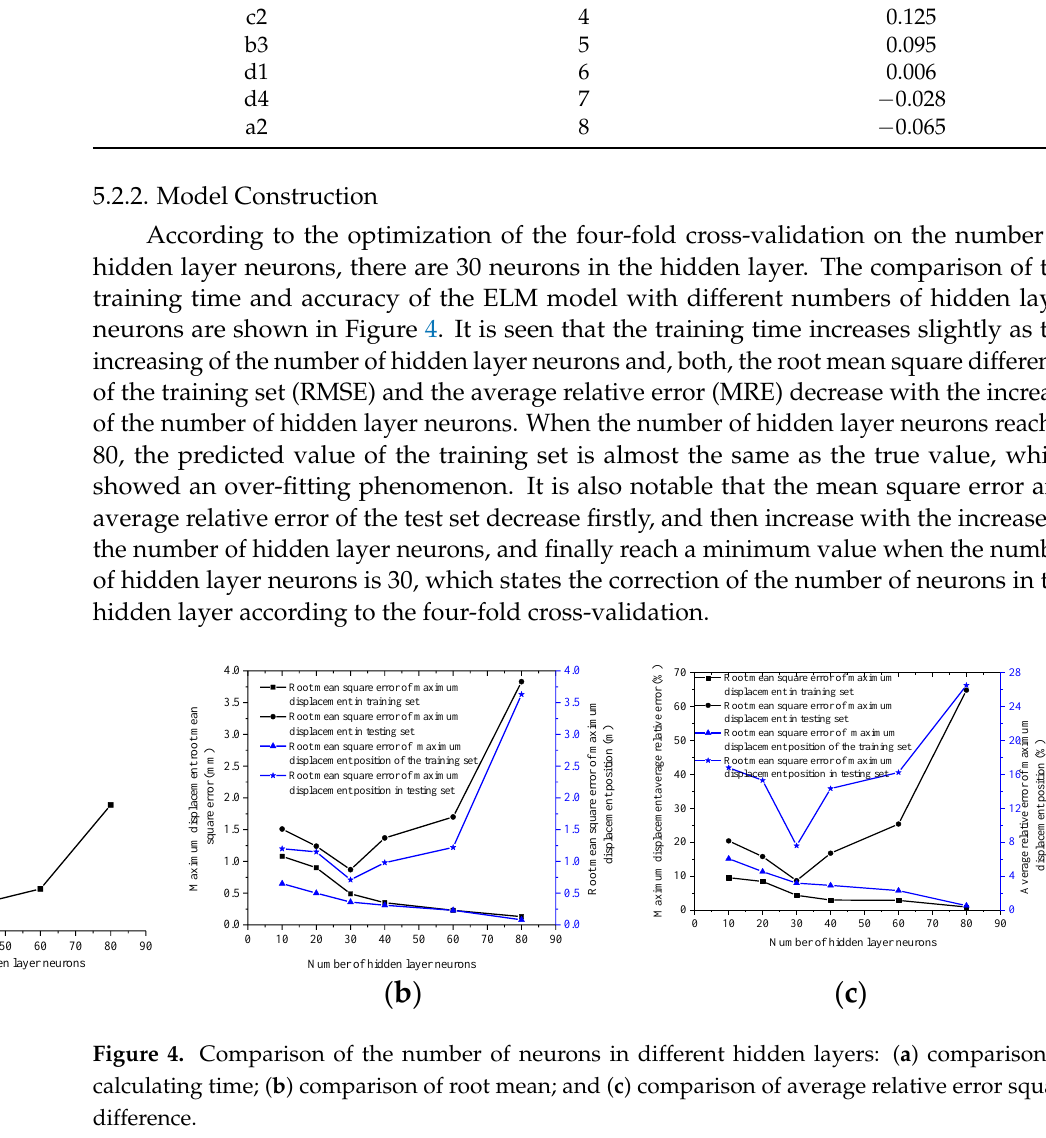
( b ) Figure 5. Comparison of the training prediction results: ( a ) training set and ( b ) testing set. 6. Conclusions The main conclusions are as follows: (1) It is feasible to use the RSARM and AIVA to simplify the influence factors of the displacement of the foundation pit. It is also advised to apply the ELM to the foundation pit displacement prediction. It is suggested to optimize and determine the hyperparame- ters of the ELM model by the K-fold cross-validation method.